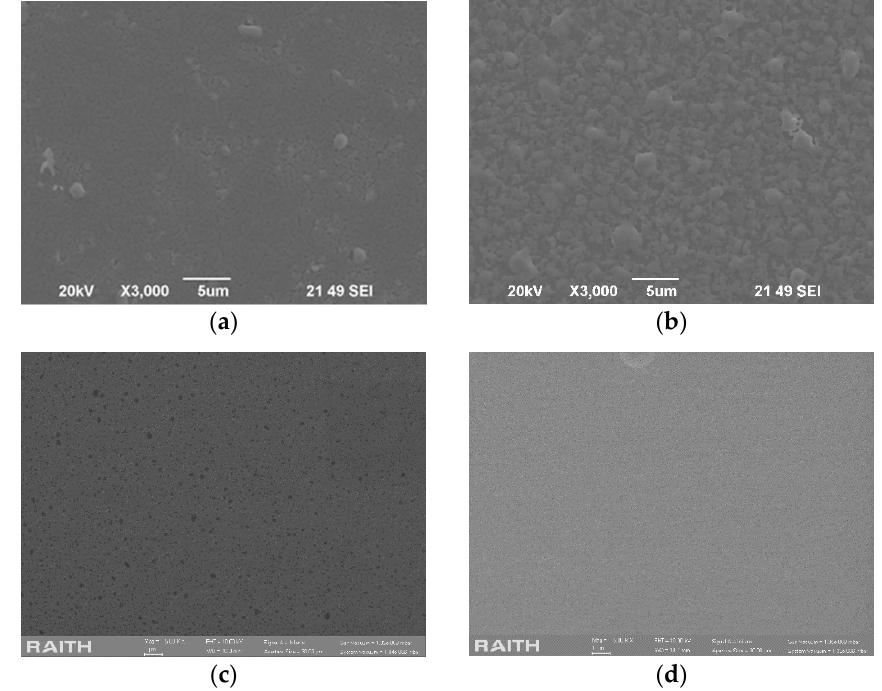
Figure 5. SEM image of p electrode metal thin films contacts on GaN laser diode, showing surface morphology after annealing for 5 min. ( a ) Ni/Ag/Zn thin films; ( b ) Ni/Ru/Ag/Au thin films; ( c ) Ni/Au thin films; ( d ) Pd/Ni/Au thin films.